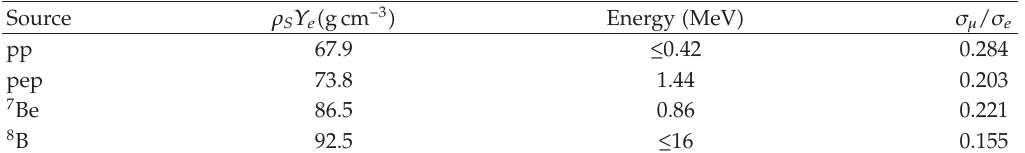
Table 1: Average electron density at the neutrino production region and energy of the relevant pp solar neutrinos fluxes. Last column shows the ratio of the electron neutrino elastic scattering with electrons cross-section to the μ (cid:6) or τ (cid:7) neutrino one. For this calculation, we have assumed a measured electron kinetic energy range of (cid:8) 0 . 05 , 0 . 4 (cid:9) , (cid:8) 1 , 1 . 4 (cid:9) , (cid:8) 0 , 0 . 8 (cid:9) , and (cid:8) 5 , 16 (cid:9) MeV for the pp, pep, 7 Be, and 8 B,